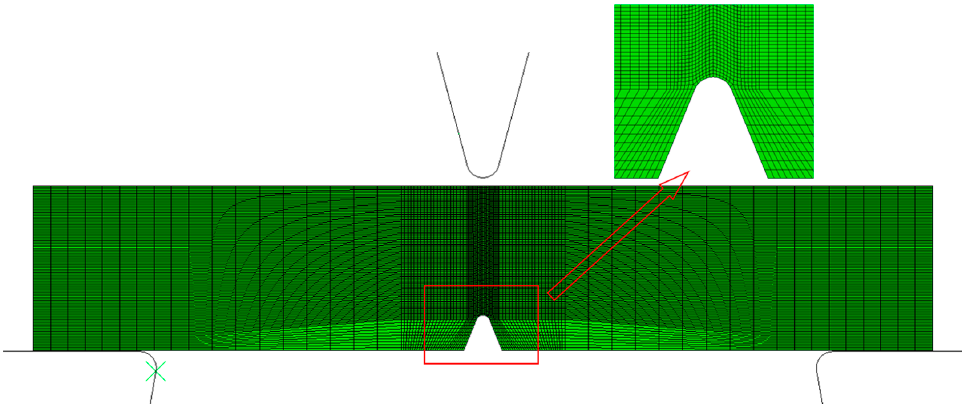
Figure 11. FE model of Charpy impact test.